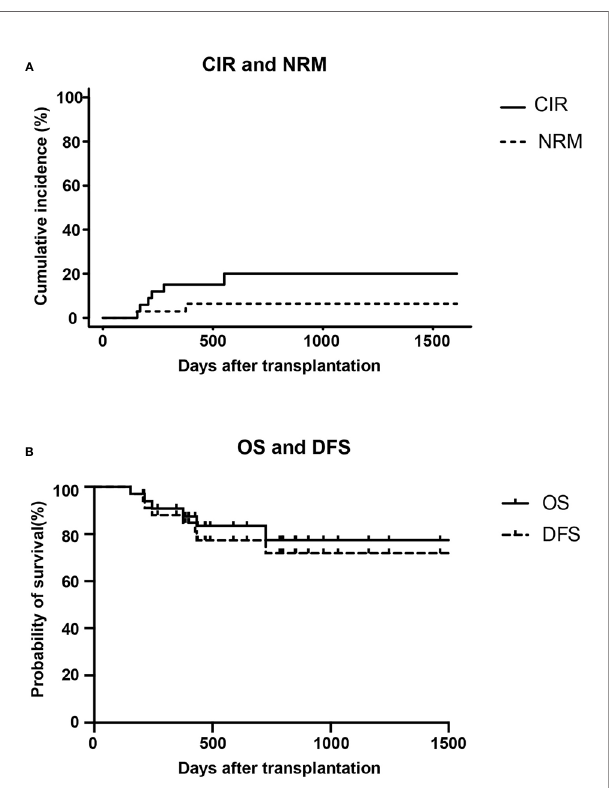
FIGURE 2 | CIR and NRM (A) and OS and DFS (B) for all patients (n = 34) after allo-HSCT.